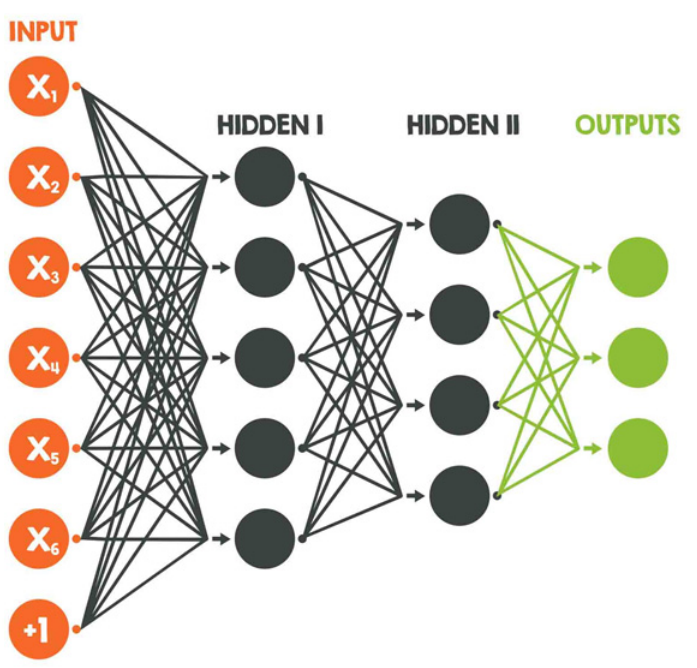
Figure 4. Artificial Neural Network (ShadeDesign/Shutterstock.com, accessed on 27 April 2022).